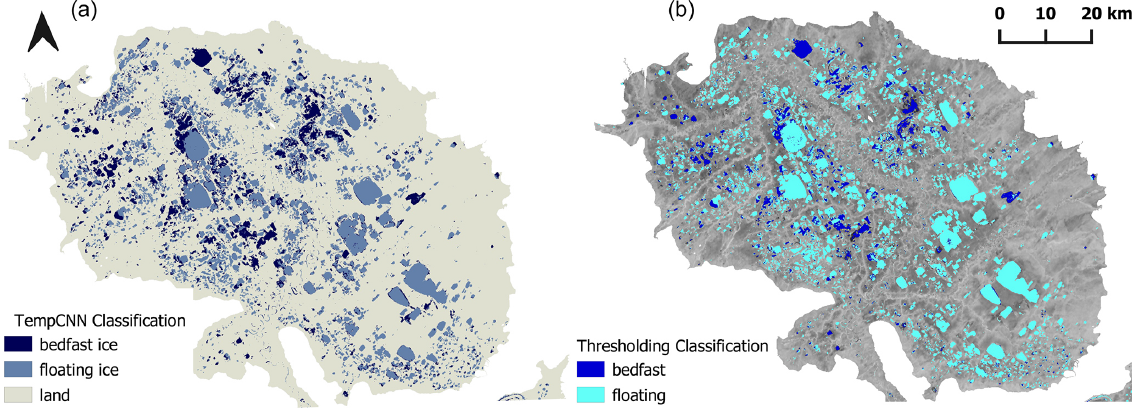
Figure 11. Comparison of the (a) TempCNN lake ice regime classification and (b) thresholding algorithm output, which defines the threshold between the two classes as a linear function of the local incidence angle (Duguay and Wang,